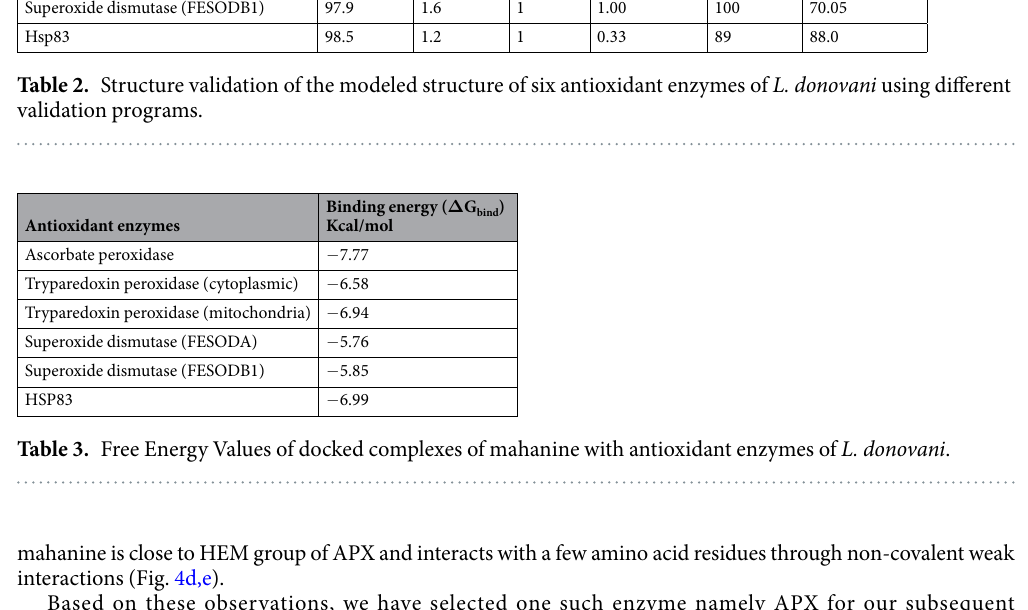
groups. Splenocytes in the 20 and 40 mg/kg b.w/day treated mice showed 2.53 ± 0.60 µ M and 4.861 ± 0.88 µ M nitrite level compared to corresponding infected (1.31 ± 0.36) and uninfected control (Fig. 5c). The efficacy of mahanine in ROS generation in murine splenocytes isolated from infected untreated and treated groups was evaluated. We observed upregulation of ROS level to 449 ± 61 and 347 ± 52 MFI units compared to those isolated from infected mice which showed the basal level of ROS (Fig. 5d). Leishmania infection impaired the T cell proliferation and therefore any ideal antileishmanial molecule should promote lymphocyte proliferation to reduce the parasite burden. Almost complete remission of parasite burden and induction of microbicidal molecules interested us to study the mahanine-induced cell-mediated immunity by measuring T cell proliferation. As expected, infected murine splenocyte showed 65% reduction of T cell pro- liferation than uninfected control. However, mahanine-treated mice exhibited 37% and 52% fold increased T cell proliferation than infected splenocytes (Fig. 5e).